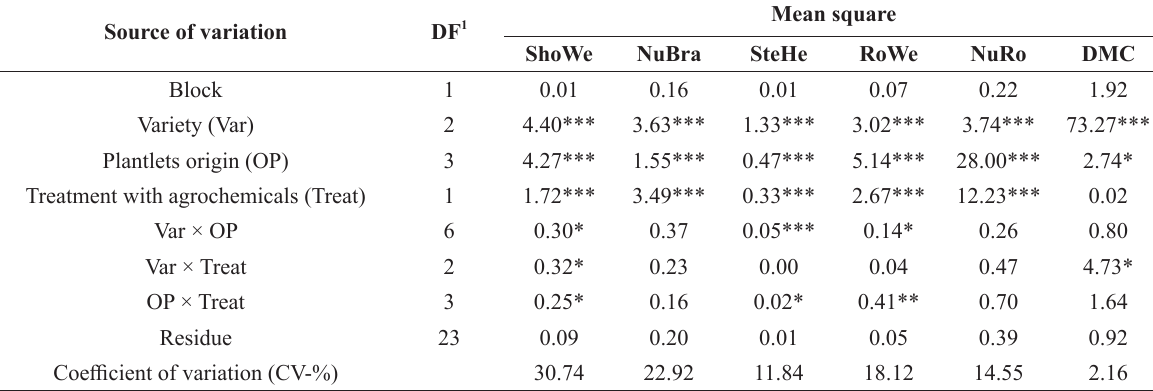
Summary of the analysis of variance of the traits of shoot weight per plant (ShoWe), number of branches per plant (NuBra), height of the stem with suitable planting pattern (SteHe), root weight per plant (RoWe), number of roots per plant (NuRo) and dry matter content of the roots (DMC) in cassava plants propagated by stem cuttings and leaf buds.